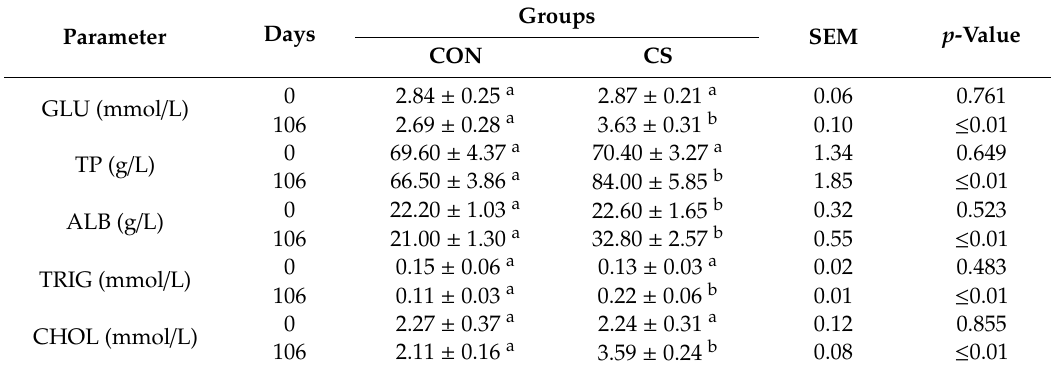
Table 4. E ff ect of cold season mix diet supplementation on serum biochemical parameters of the